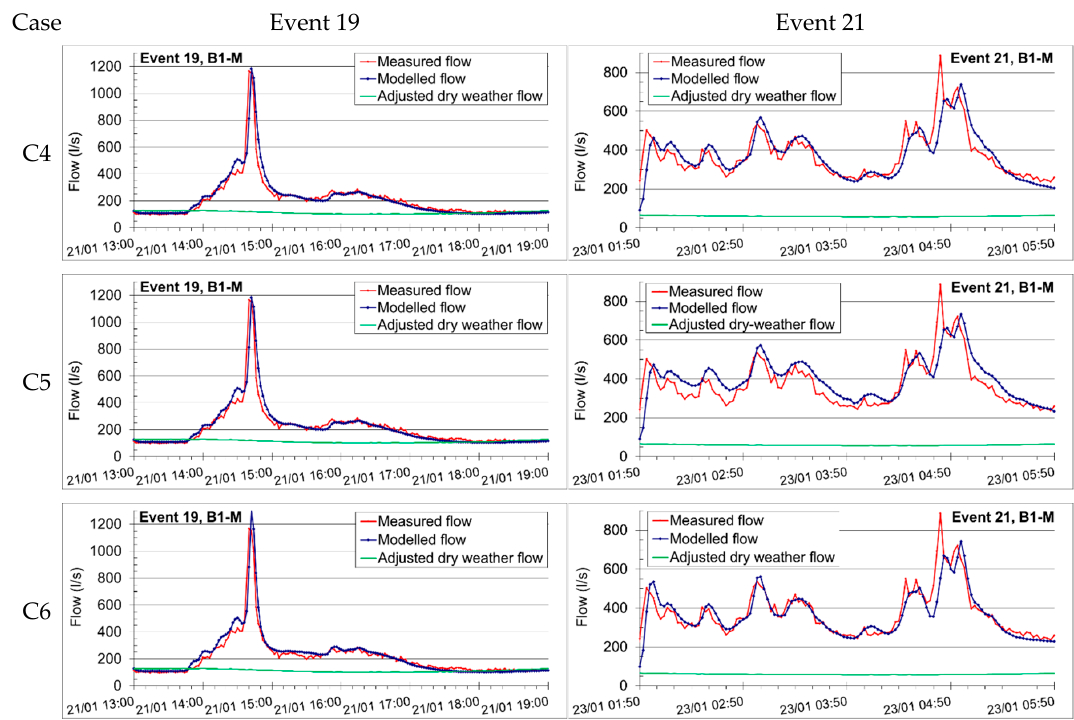
Figure 7. Hydrographs of two rainfall events for assessments C4, C5 and C6.